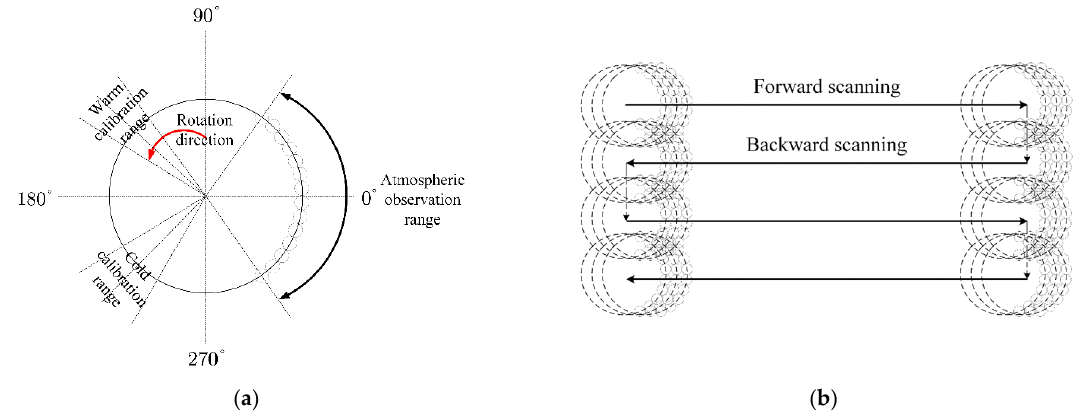
Figure 2. The operational principle of the GEO microwave antenna in this study. ( a ) 1-D LFS. ( b ) 2-D OSS.